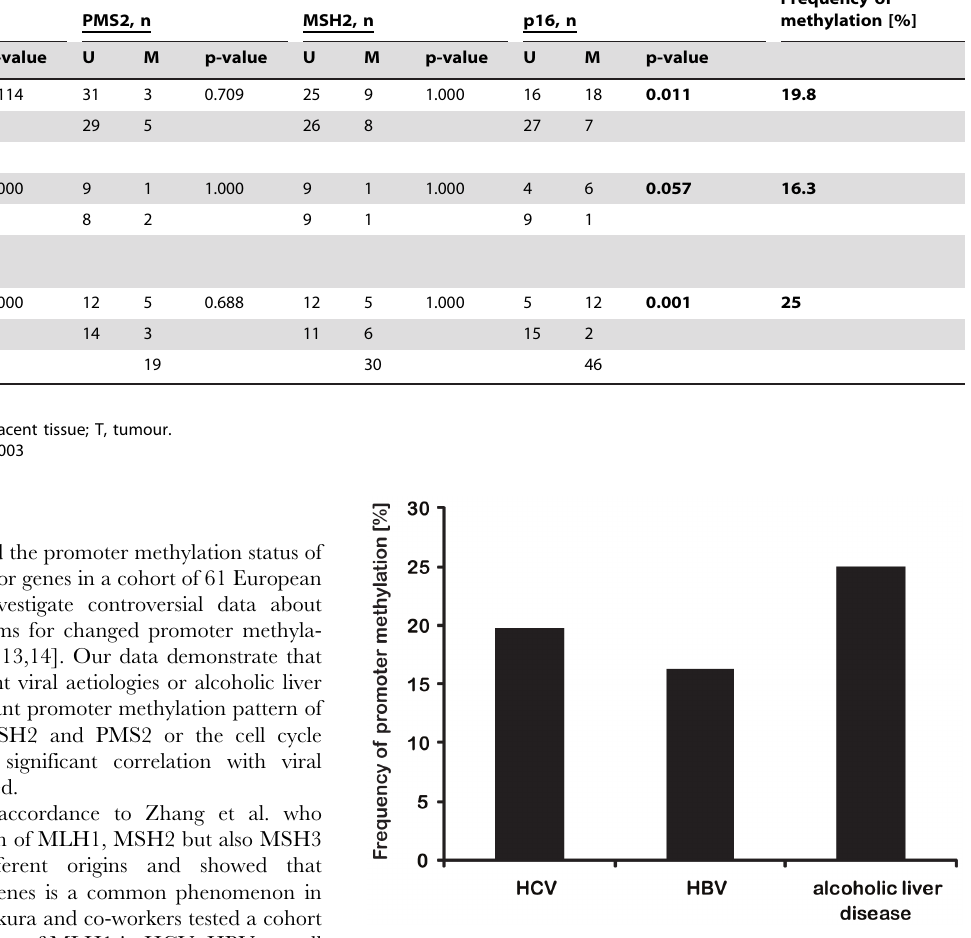
Figure 2. Frequency of promoter methylation. Promoter methyl- ation of MLH1, PMS2, MSH2 and p16 was determined in HCC of different origins. As presented in bar graph, the frequency of methylation in the tested promoters and tissues was 19.8% in HCV infected, 16.3% in HBV infected and 25% in patients with alcoholic liver disease.